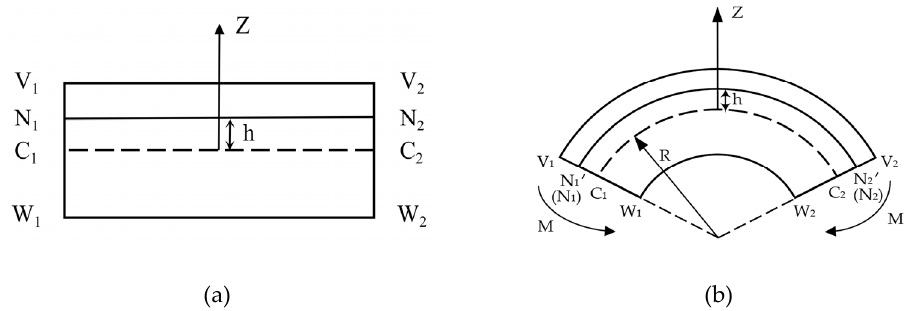
Figure 5. Schematic diagrams before and after sheet bending: ( a ) Before Bending. ( b ) After bending.